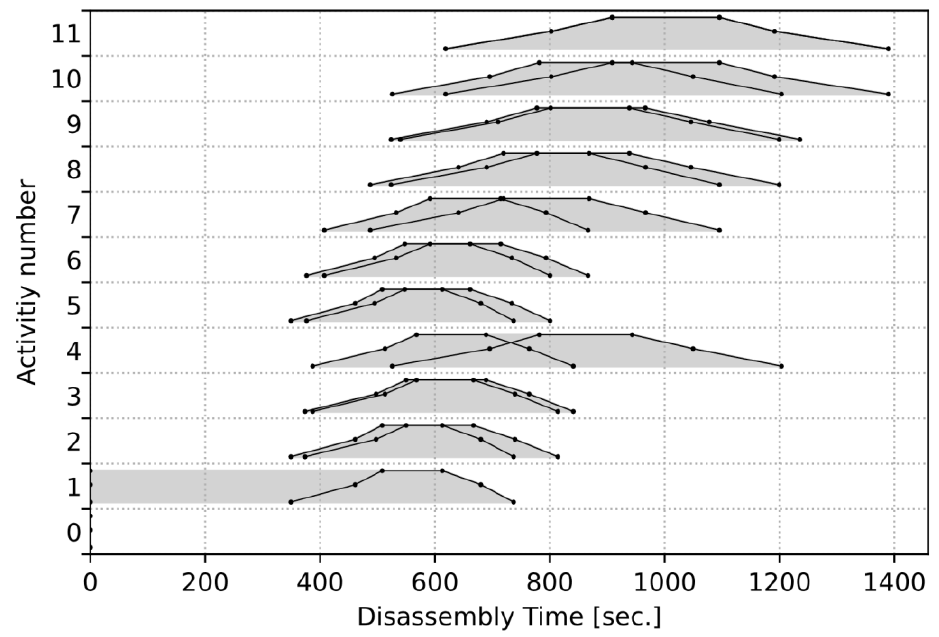
Figure A3. Scenario “Two Workers”: resulting fuzzy Gantt chart for each disassembling Figure A3. “ ” fuzzy Gantt chart for each disassembling step.